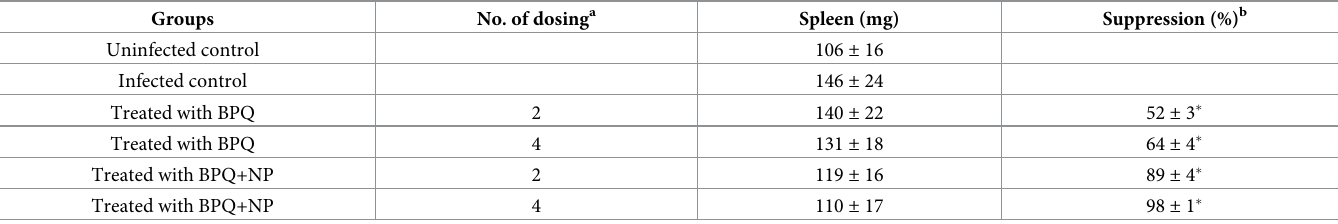
Table 5. In vivo antileishmanial activity of BPQ and BPQ+NP on infected mice using CMA method (mean ± σ , n = 5).